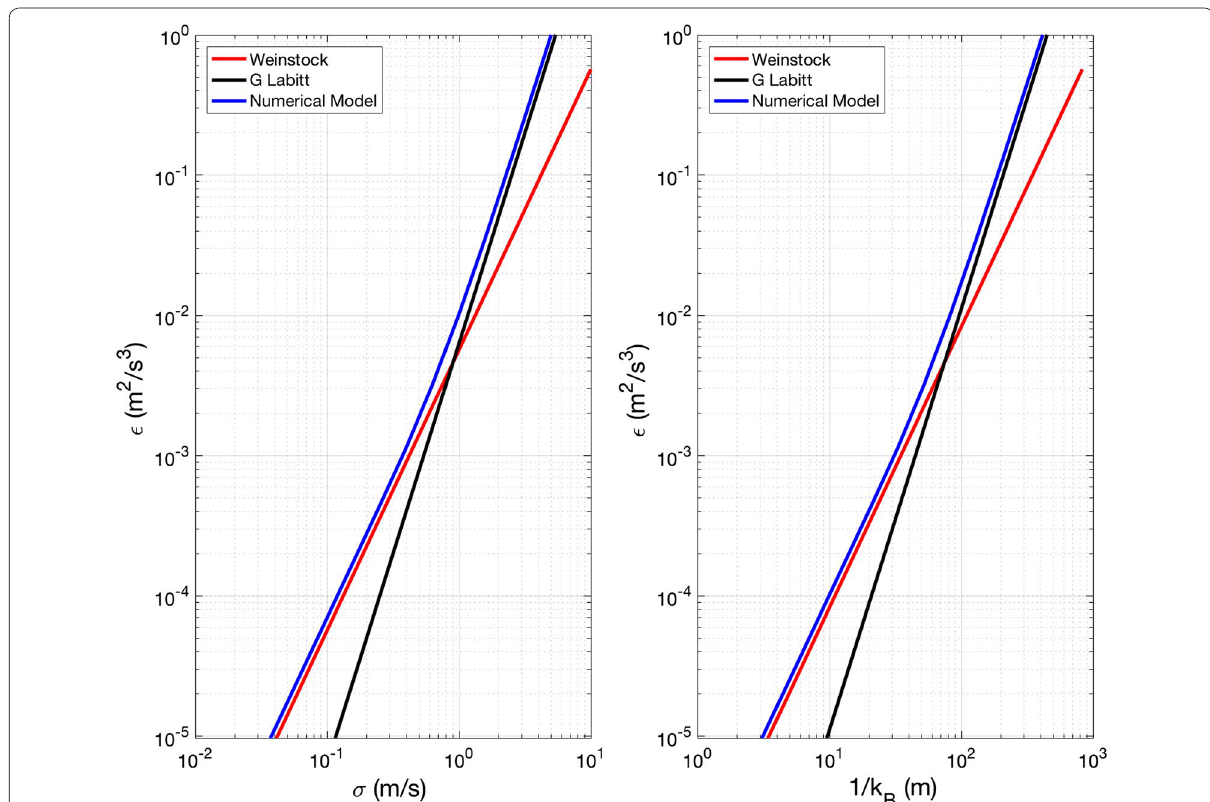
Fig. 1 Plot of the TKE dissipation rate ε against σ (left) and the corresponding buoyancy length scale 1/ k B (right). The blue line shows the numerical model (Eq. 54). The red line shows the Weinstock (1978, 1981) formulation, while the black line is the Labitt formulation. Note that because the constant C K < 1, the numerical model does not asymptote to Weinstock and Labitt